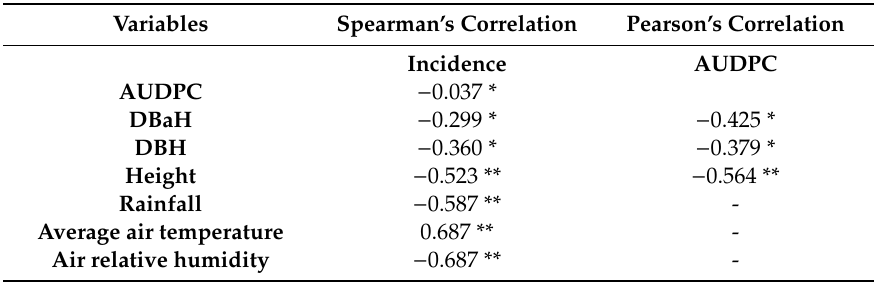
Table 2. Pearson’s and Spearman’s correlation among bacterial leaf blight incidence, area under the disease-progress curve, growth-related variables, and correlation between bacterial leaf blight incidence and meteorological data over time.